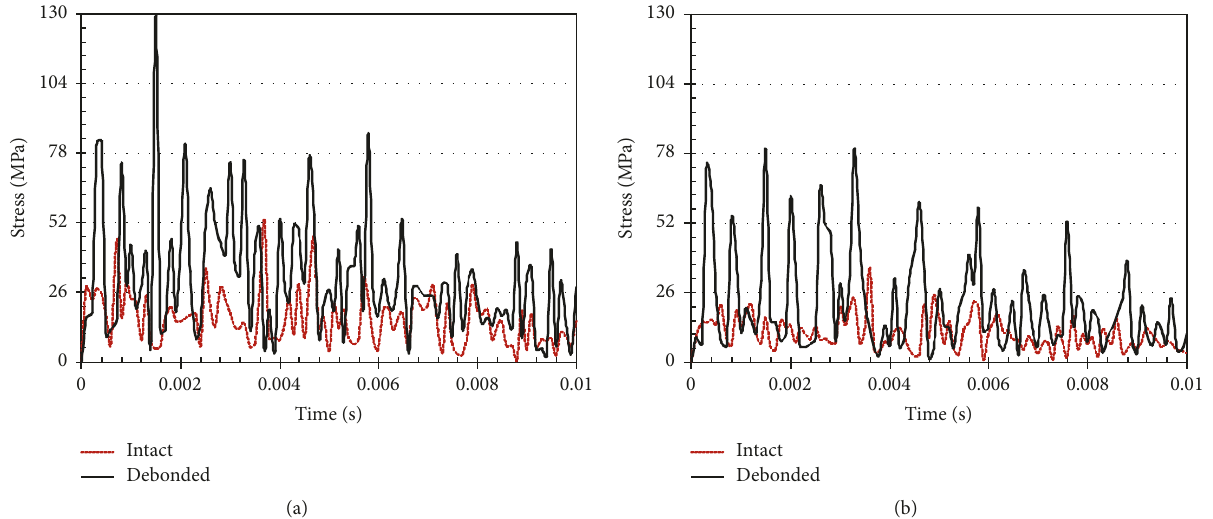
Figure 21: Transient time history of the von Mises stress calculated at the points [79]: (a) centre of the top face sheet and (b) boundary of the debonded zone on the top face sheet.